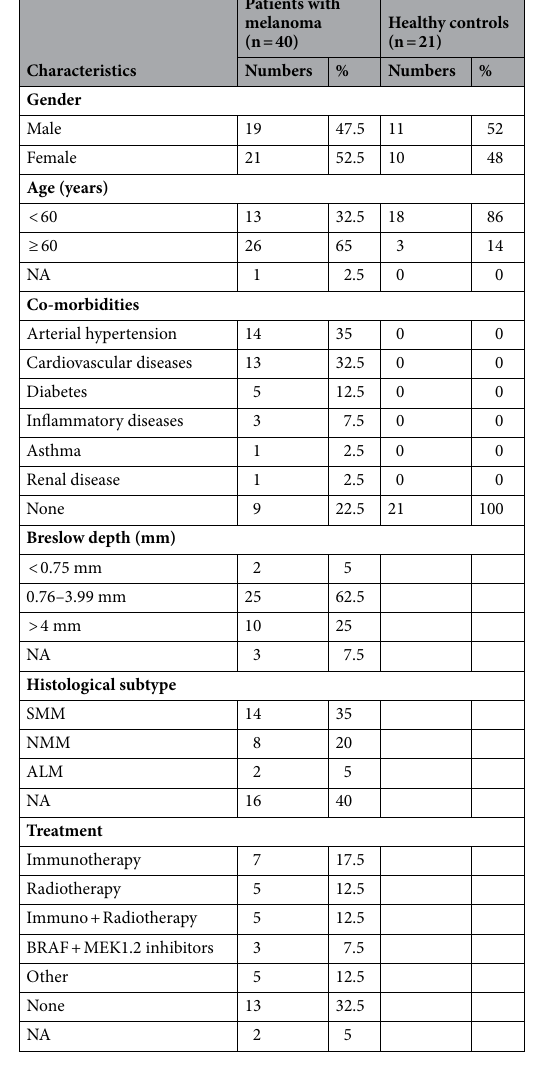
Table 1. Clinical characteristics of patients with melanoma and healthy controls. 40 patients with melanoma and 21 healthy individuals were included in the study. SMM superficial malignant melanoma, NMM nodular malignant melanoma, ALM acral lentiginous melanoma, NA not